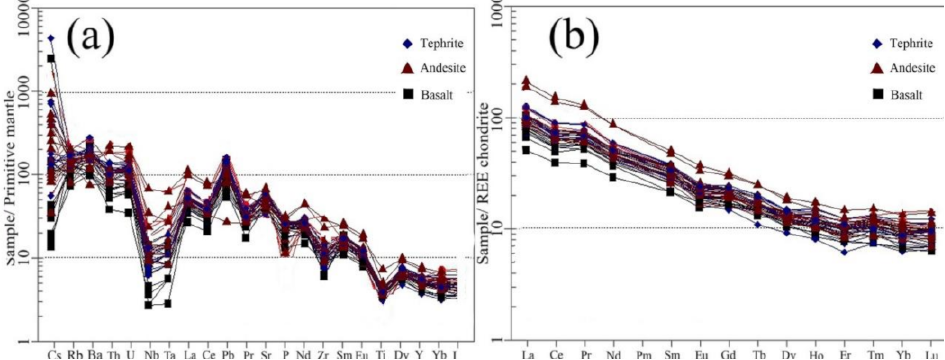
Figure 8. ( a , b ) Primitive mantle-normalized multi-element spider diagrams for the studied mafic dyke samples. Primitive mantle and REE chondrite values are taken from